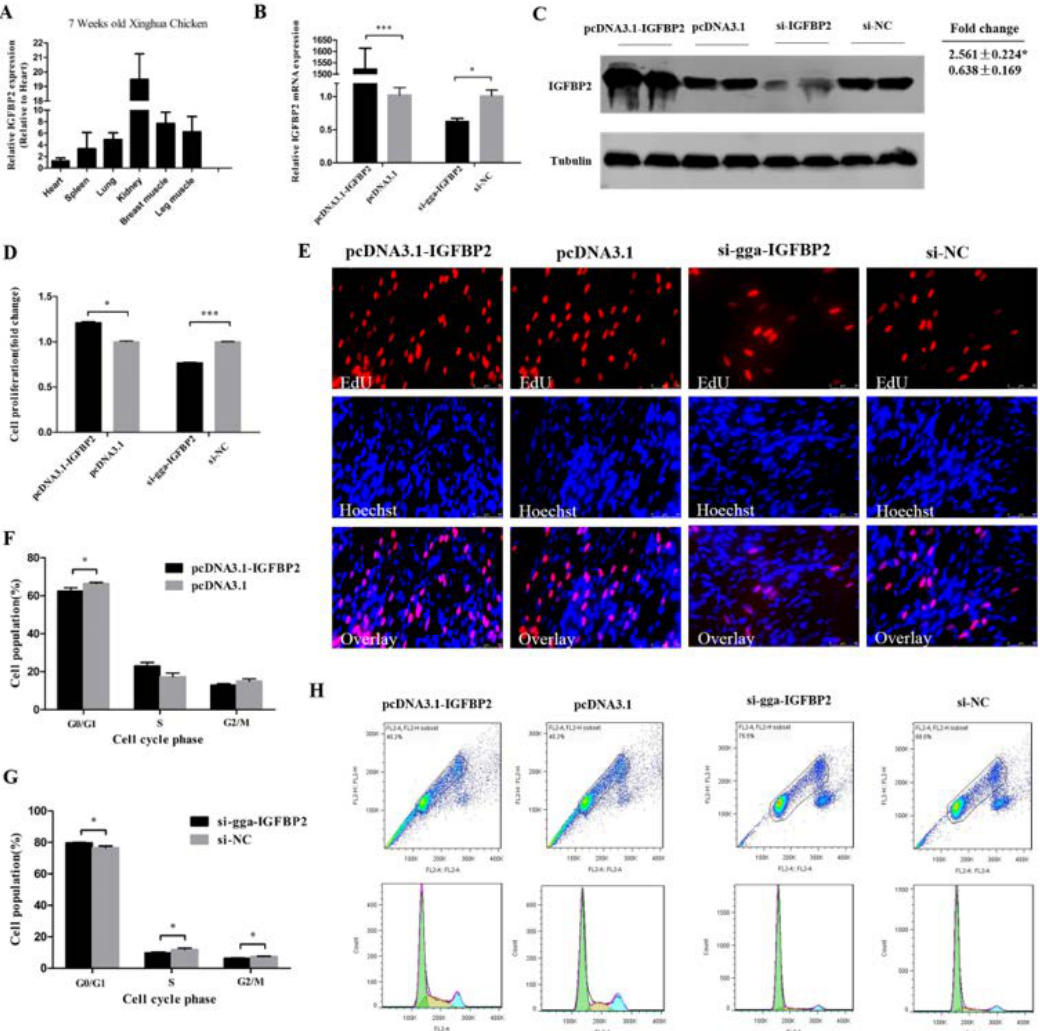
Figure 4. IGFBP2 facilitates the cell cycle progression of myoblasts. ( A ) The relative mRNA expression of IGFBP2 in six different tissues of 7 week old Xinghua chickens. ( B , C ) The mRNA and protein level of IGFBP2 after IGFBP2 overexpression and knockdown. ( D , E ) The proliferation rate and EdU assay of CPM cells after overexpression and inhibition of IGFBP2. ( F – H ) Flow cytometry raw data and statistical